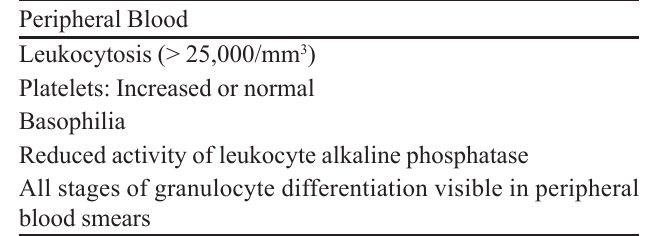
TABLE I - Laboratory findings of peripheral blood of CML patients, at a chronic